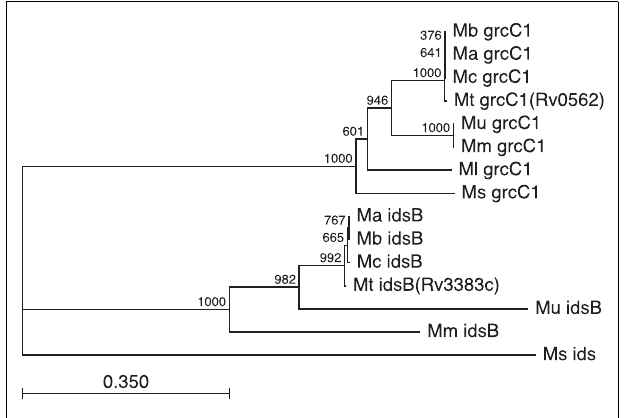
FIGURE 6 | Conservation of GGPP synthases in the MTC and closely related mycobacteria. GGPP synthases appear to have assumed additional wider importance in mycobacteria, as evidenced by the retention of Rv3383c/ idsB despite loss of the remaining isoTb operon. Retention of orthologs for both Rv3383c/ idsB and Rv0562/ grcC1 , based on both sequence similarity and genome positioning, is found in all sequenced members of the Mycobacterium family derived from the last common ancestor of the MTC and M. marinum . Species designated by genus and species initials (i.e., Mt, M. tuberculosis ; Mb, M. bovis ; Ma, M. africanum ; Mc, M. canettii ; Mm, M. marinum ; Mu, M. ulcerans ; Ml, M. leprae ; Ms, M. smegmatis ) and genes as annotated in the Mtb genome (i.e., either grcC1 or idsB ), with the next closest ids homolog from M. smegmatis shown as the outgroup sequence). Not that while many of the listed species do contain other IDS encoding genes, these are relatively distantly related to those shown